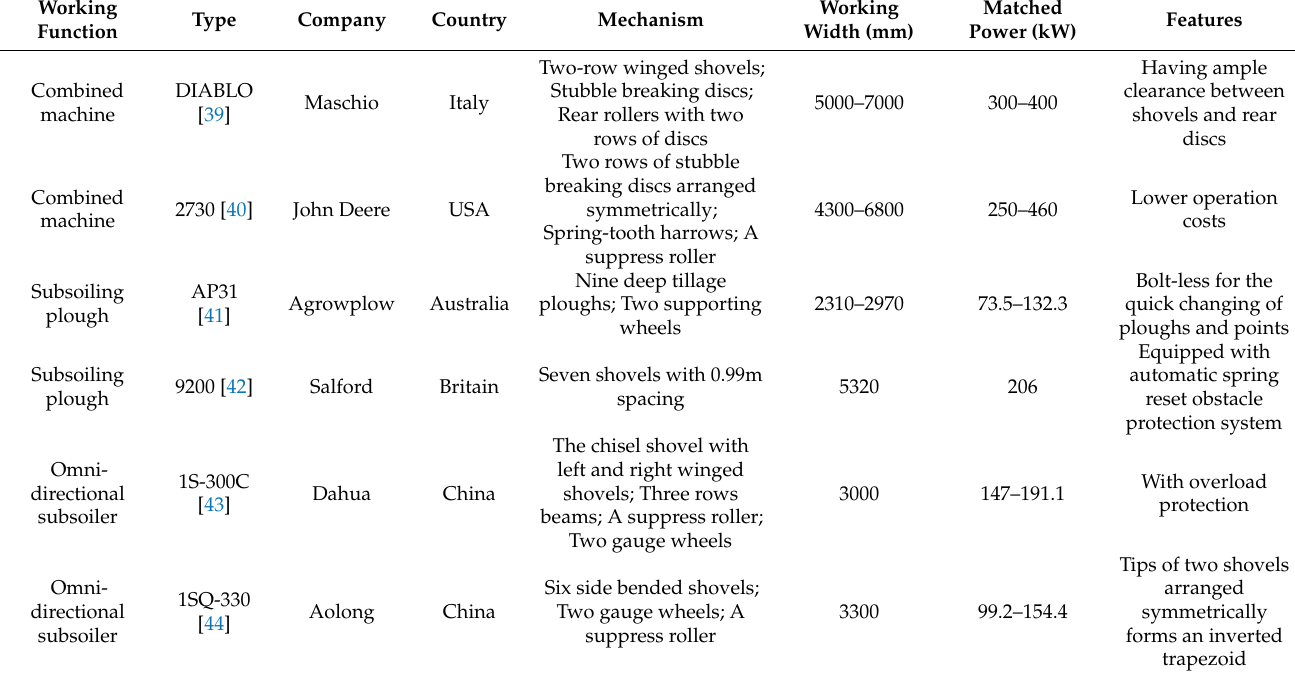
Table 2. Comparison of different kinds of subsoiling